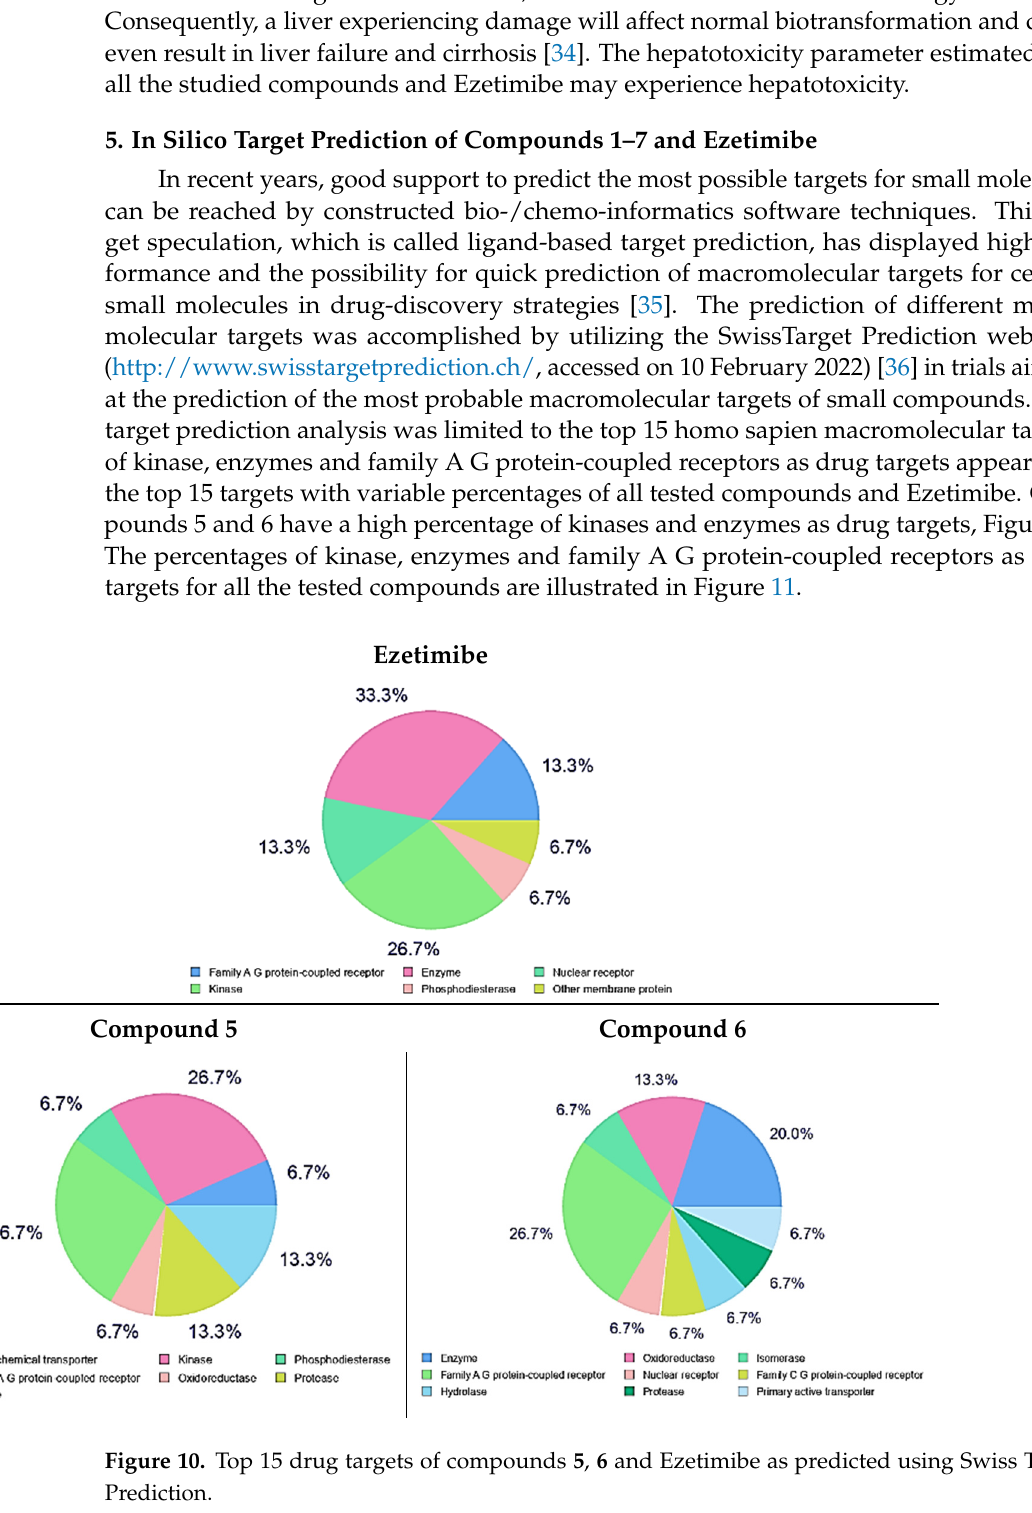
Figure 11. Percentage of kinase, enzymes and family A G protein-coupled receptors as drug targets of compounds 1 – 7 and Ezetimibe as predicted using Swiss Target Prediction. 6. Experimental Section 6.1. Chemistry 6.1.1. Materials and Methods